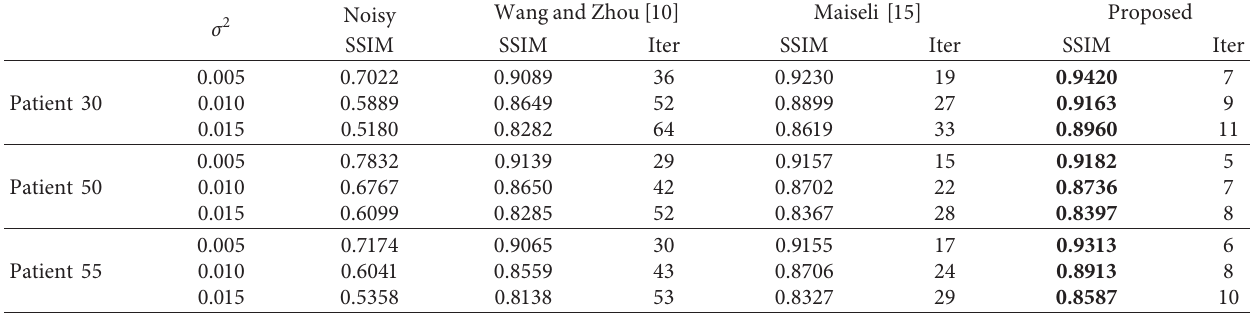
Table 2: SSIM-index values of the images in Figure 1 are affected by different σ 2 values of zero-mean white Gaussian noise and restored from different methods with their corresponding iteration